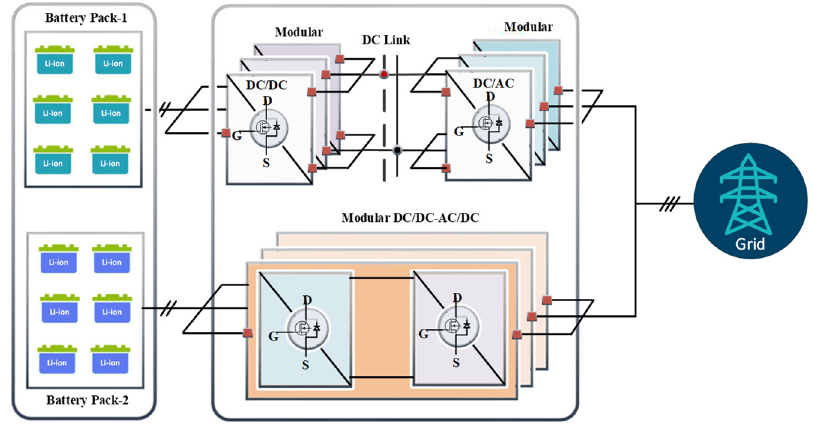
Figure 4. PE configuration 3: PCS-2 for battery pack-1 and PCS-1 for battery pack-2.